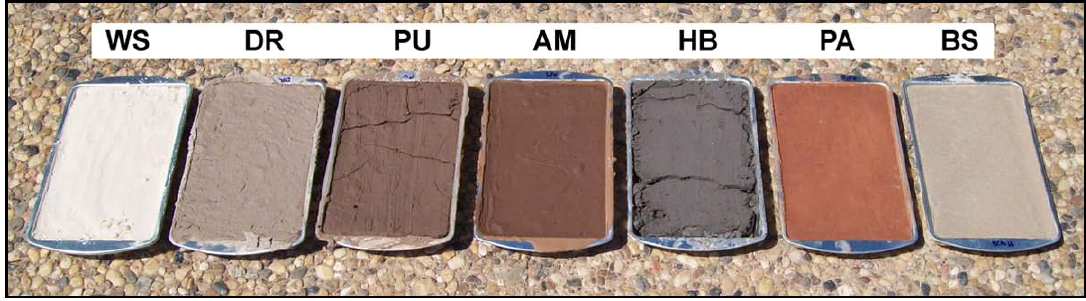
Figure 2. Trays holding the seven soils for reflectance measurements.